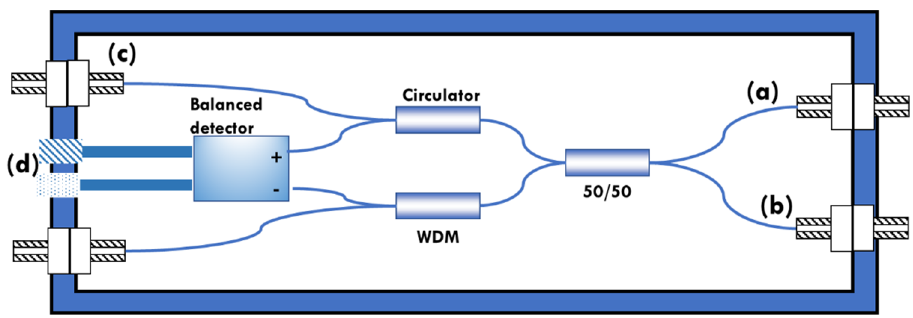
Figure 4. Scheme of the commercial all-fiber Michelson interferometer. ( a ) is measurement output; ( b ) is reference output; ( c ) is SLED input; ( d ) is electrical output.